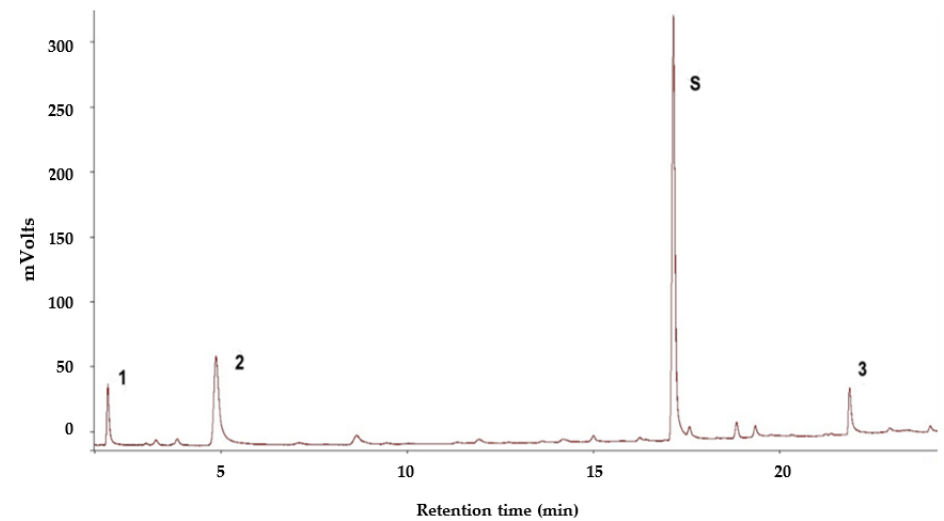
Figure 1. GC chromatograph of headspace volatiles from S. granarius . Numbered peaks: 1 = ethanol;